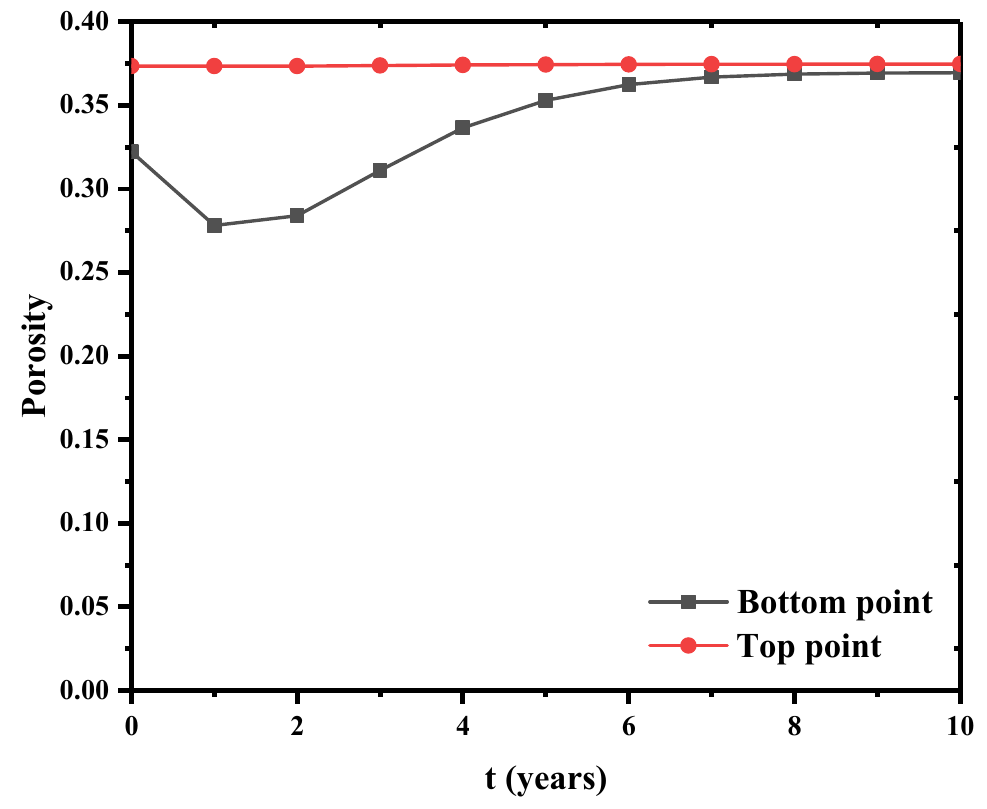
Figure 12. Porosity evolution at bottom and top boundaries.